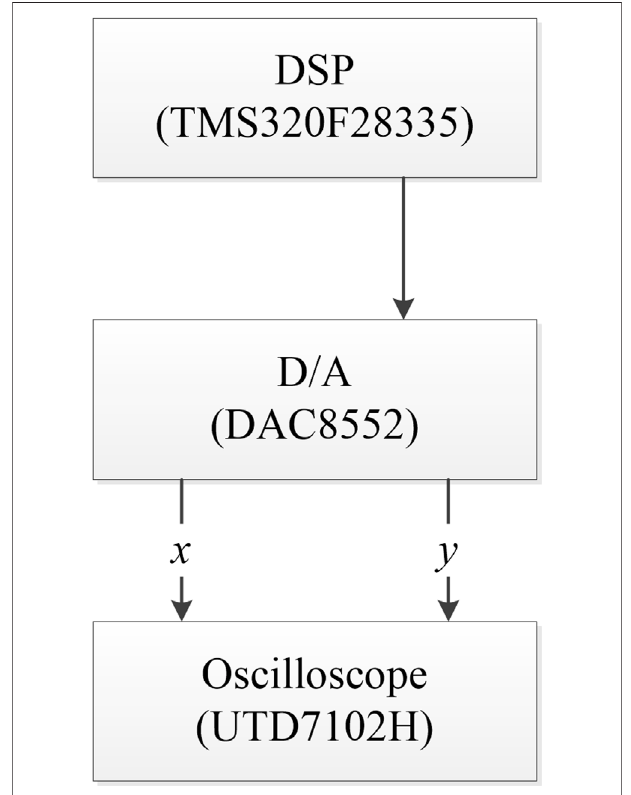
FIGURE 14 | Flow chart.